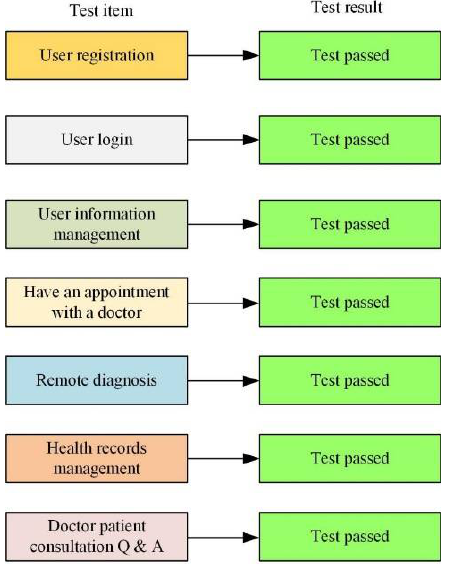
Figure 7. Test of the algorithm (drawn according to the test results after research and design com- bined with data).